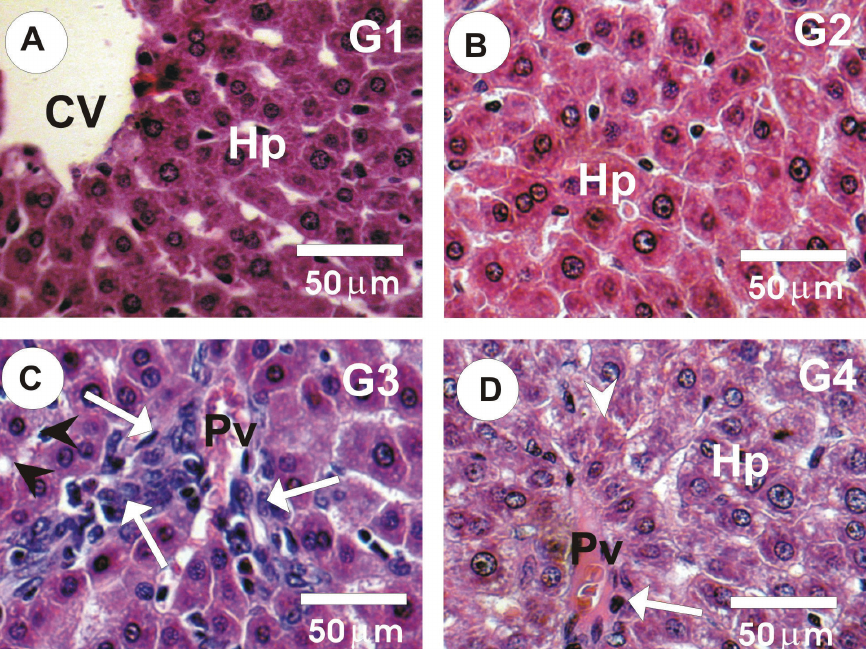
FIGURE 1 - Photomicrographs of rat liver sections stained by HE; (A&B) Rat testes in control (G1) and GSPE (G2) groups showed normal architecture of the hepatocytes (hp) with central vien (CV); (C) Liver sections of Gleevec group (G3) exhibited marked cellular infiltrations (White arrows), moderate atrophied vacuolar degeneration hepatocytes (arrow heads), and many of apoptotic cells; (D) Liver sections treated Gleevec with GSPE (G4) exhibited a mild degree of improvement in hepatocytes that exhibits moderate vacuolated hepatocytes (arrow heads) with mild cellular infiltrations (White arrows) and moderate congestion in central and portal